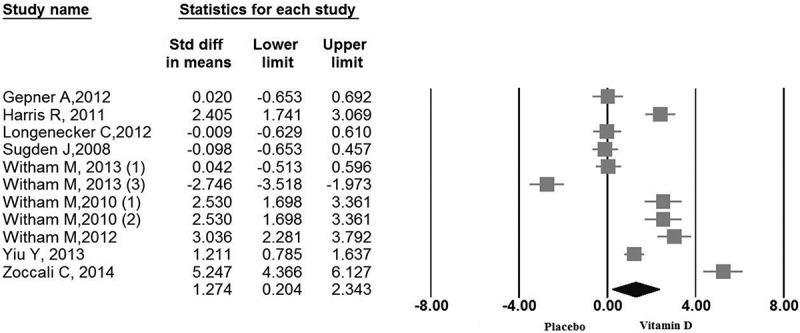
Forest plot displaying weighted mean difference and 95% confidence intervals for the impact of vitamin D supplementation on flow mediated dilation.